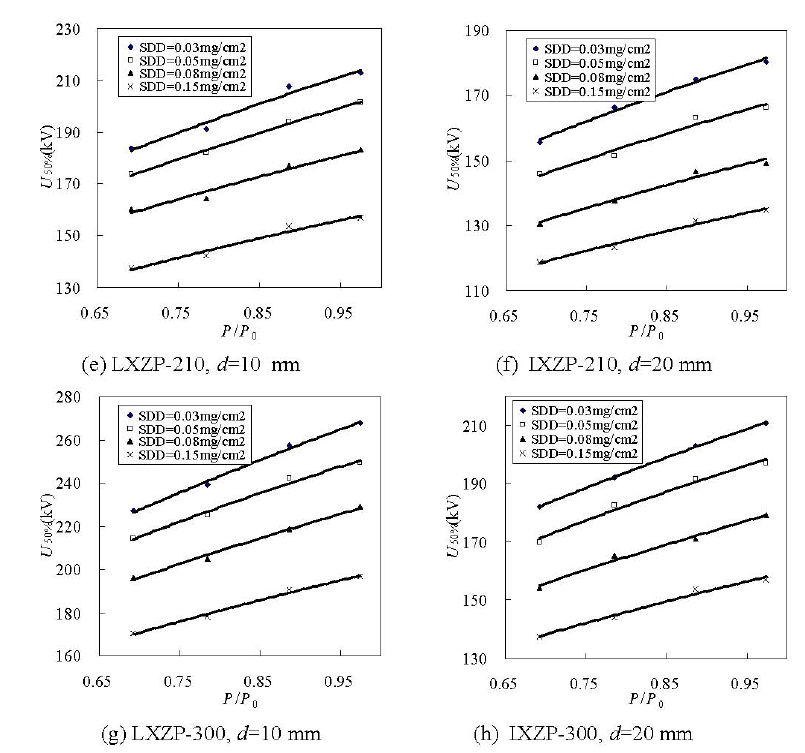
Figure 11. Relationship between U